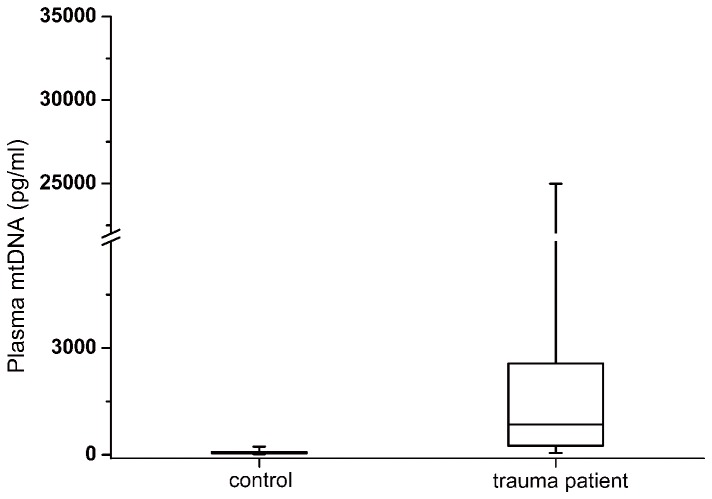
Box plots of the plasma mitochondrial DNA concentration between the trauma patients and healthy controls.Plasma mtDNA concentrations presented as median values (line across the boxes), IQR (limits of the boxes), and 5th to 95th percentiles (whiskers). The plasma mtDNA concentration in the traumatic patients was significantly higher than for the healthy controls (P<0.001).